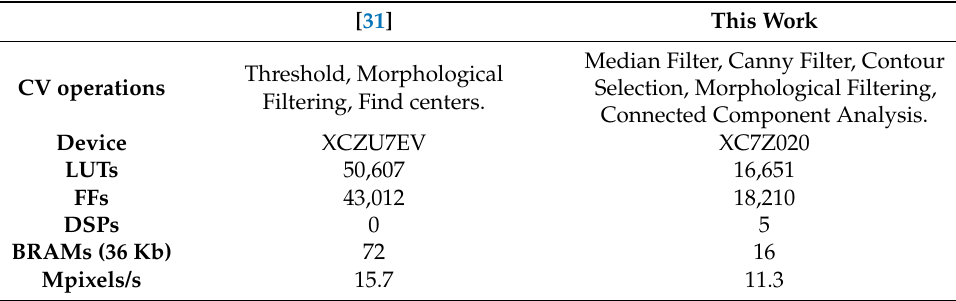
Table 2. Comparison with the FPGA design for bolt inspection in